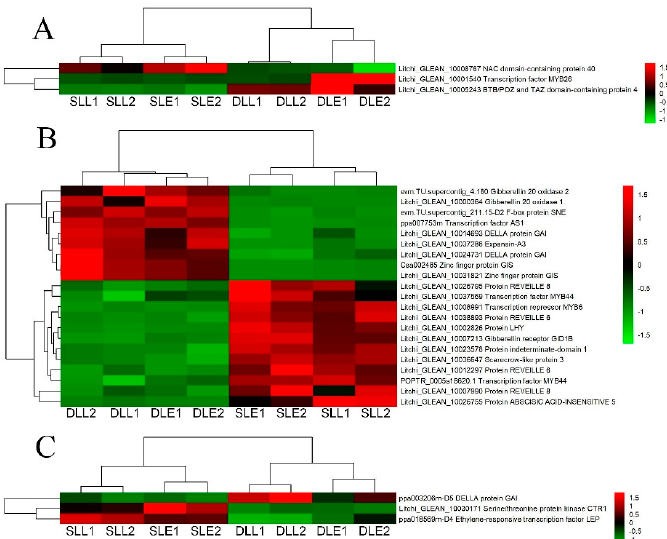
Figure 7. Heat map diagram showing the GA-related differentially expressed genes (DEGs) between senescing and developing panicle leaves. ( A ) The unique DEGs expressed at an early stage. ( B ) The DEGs simultaneously expressed at early and later stages. ( C ) The unique DEGs expressed at a later stage. Litchi trees were transferred to a growth chamber at 18 °C to induce panicle leaf senescence when panicle primordia emerged. The other trees were transferred to a growth chamber at 26 °C to encourage panicle leaf development. FPKM values of the samples were normalized to Z-score.